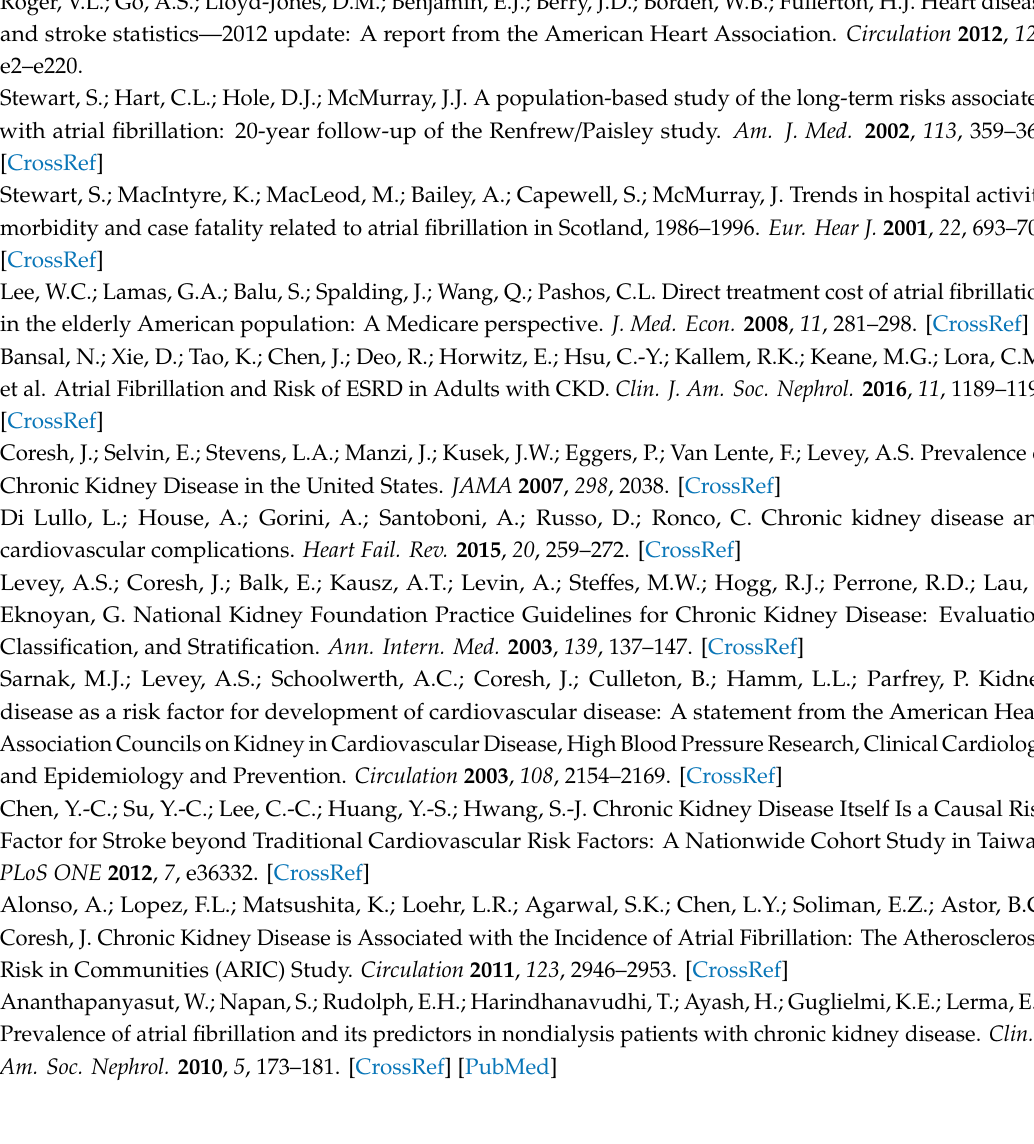
Figure S1: Cumulative incidence of ESRD amongst participants with non-AF, prevalent AF and incident AF. Figure S2: Cumulative survival curves amongst participants with non-AF, prevalent AF and incident AF. Figure S3: Cumulative survival curves free of cardiovascular death amongst participants with non-AF, prevalent AF and incident AF. Figure S4: Cumulative survival curves free of stroke of systemic thromboembolism amongst participants with non-AF, prevalent AF and incident AF. Figure S5: Cumulative survival curves free of acute myocardial infarction amongst participants with non-AF, prevalent AF and incident AF. Table S1: ICD-9-CM codes used to identify chronic kidney disease, atrial fibrillation, comorbidities and the cause of death. Table S2: Risks for ESRD, stroke or systemic thromboembolism, acute myocardial infarction and mortality among patients with CKD by AF status after re-classification of incident AF as prevalent AF (non-AF as the